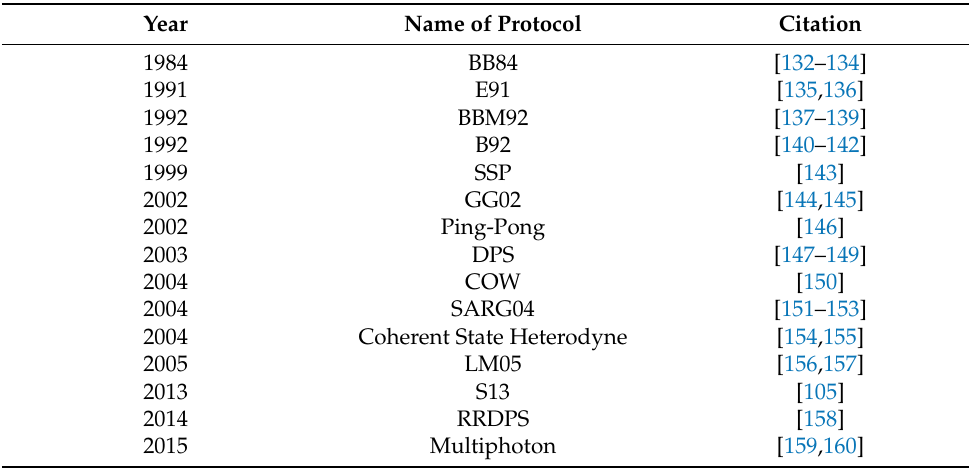
Table 2. QKD Protocol based on Heisenberg’s Uncertainty